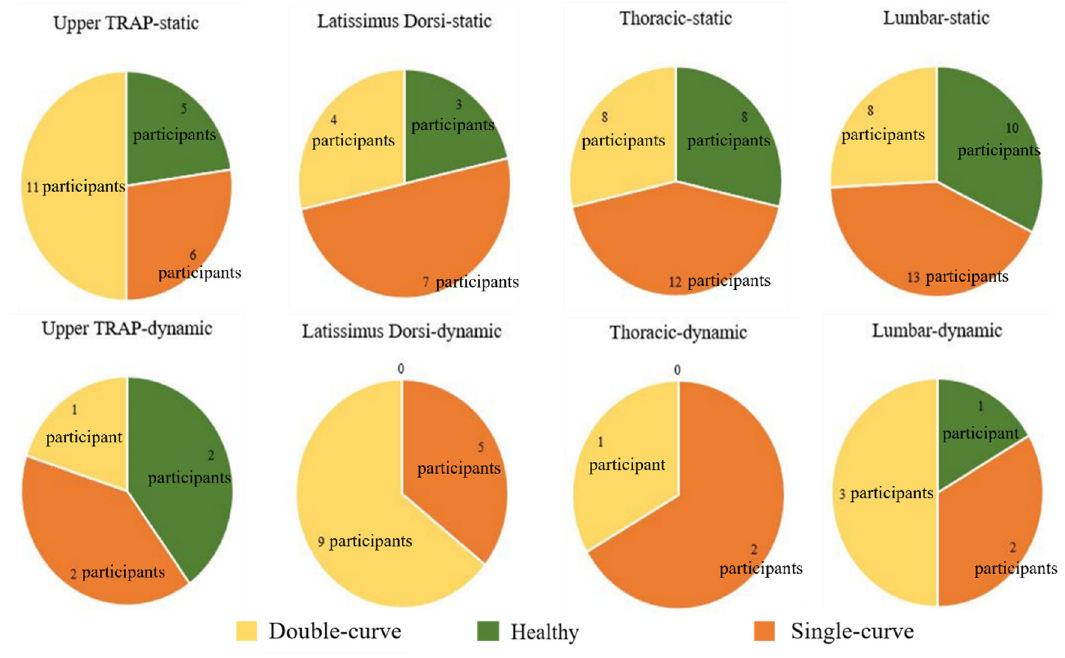
Figure 7. Participants with significant differences between left and right muscles based on group.